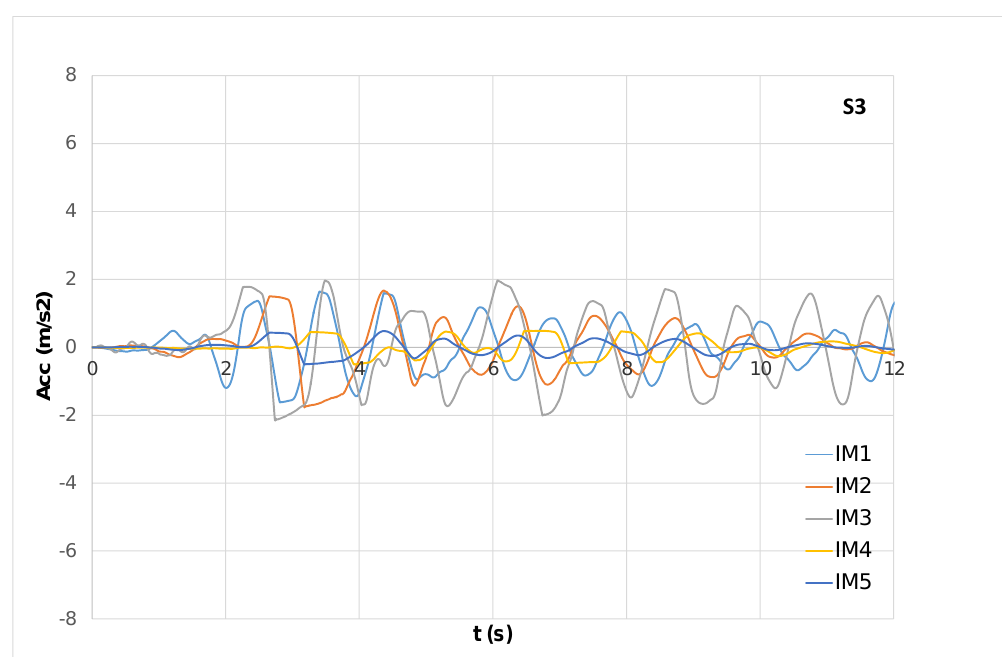
Figure 8. Base acceleration (S3).